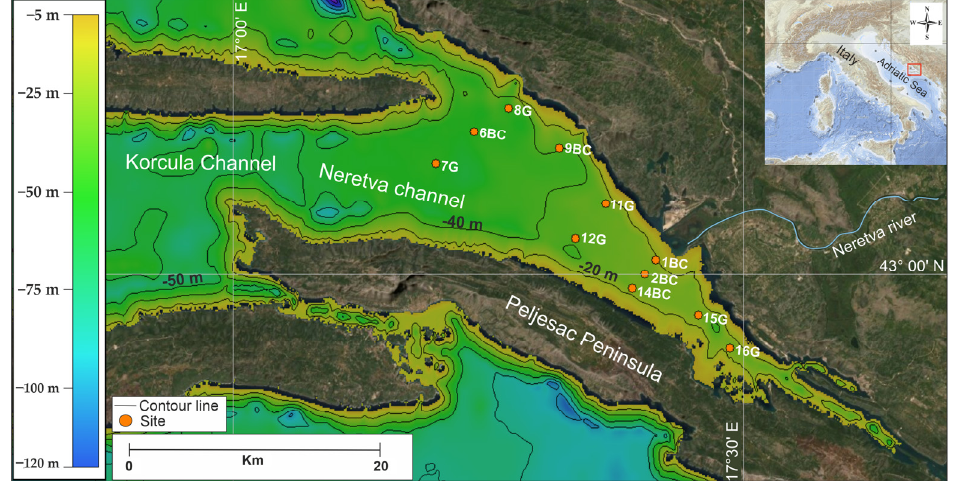
Figure 1. Map of the study area with the locations of the 11 investigated samples (orange circles). Shaded relief image derived from bathymetric data with sun illumination from NW, 45° over the horizon and no vertical exaggeration. Elevation and bathymetry data from EMODnet gridded data (www.emodnet.eu/bathymetry, accessed on 13 October 2022 ). Bathymetry contour interval is 20 m. Red box in the inset indicates the study area.